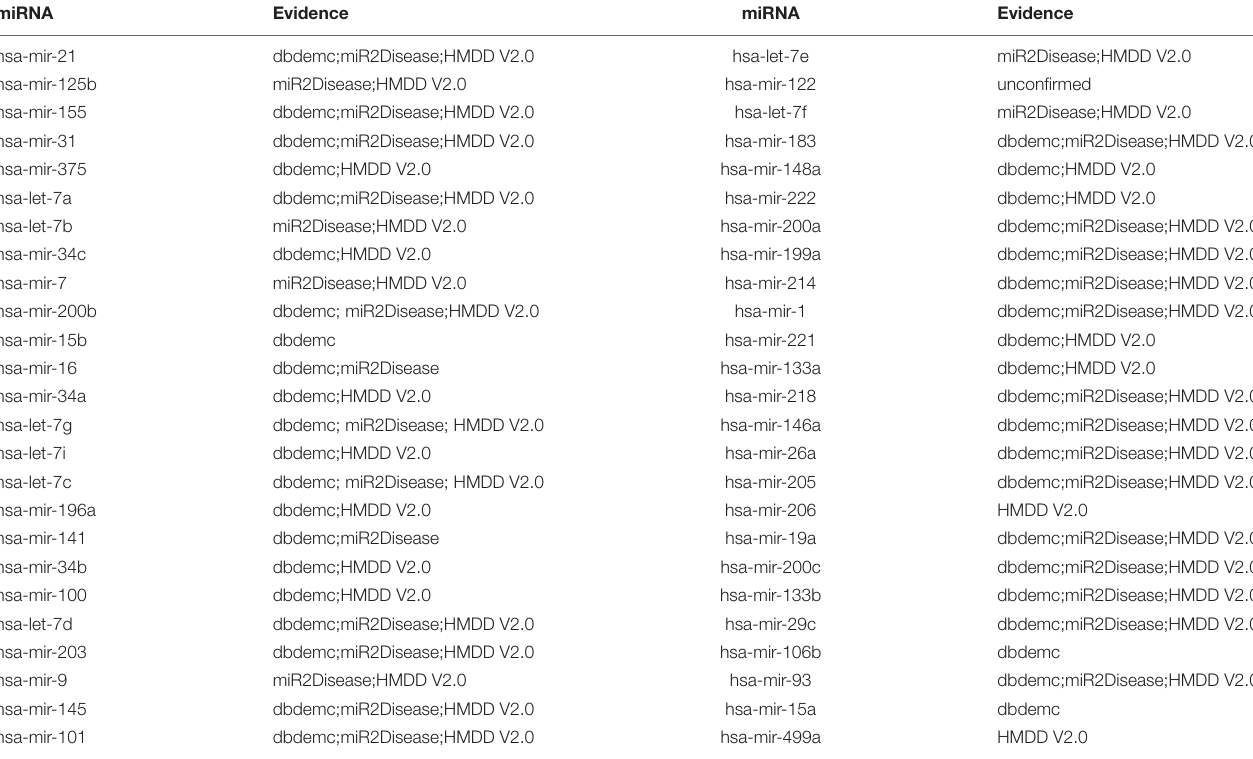
TABLE 5 | Prediction of the top 50 predicted miRNAs associated with LN as a new disease by removing all known associations containing LN in HMDD V2.0 database.